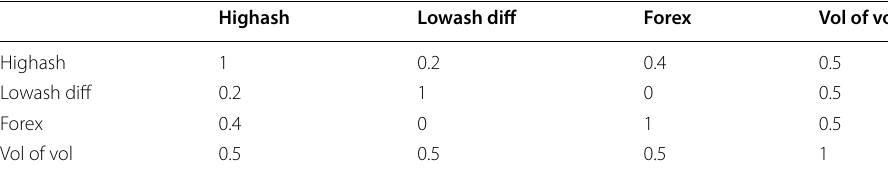
Table 2 Correlation parameters